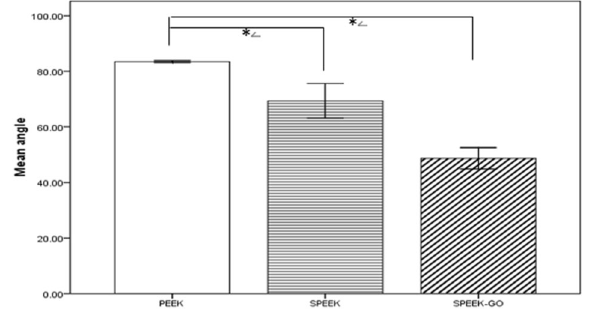
Fig. 6 Statistical analysis of contact angles (CAs) of different material surfaces. The SPEEK-GO group was signi fi cantly different from the other two groups. ( P < 0.01) The contact angle measurements showed that the CA values of PEEK, SPEEK, and SPEEK-GO were 83.47 ± 0.15°, 69.33 ± 2.52°, 48.67 ± 1.53°,